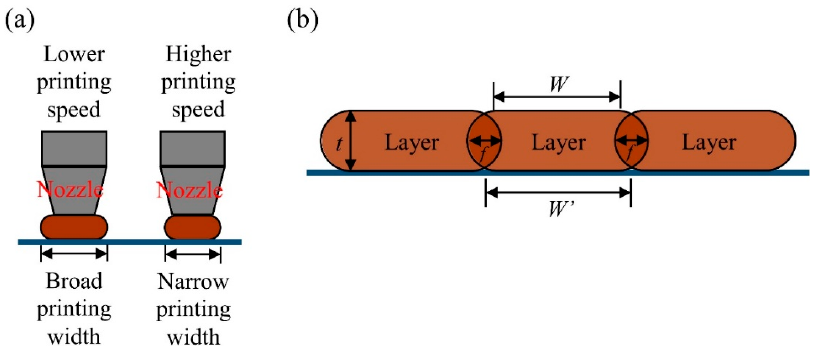
Figure 7. SEM micrographs of the surface morphologies of the WPC parts printed at various printing speeds.